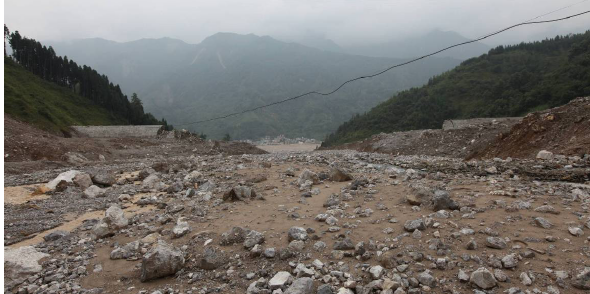
Fig. 18. Check dam destroyed by the 8.13 debris flow near the outlet of the Wenjia gully.